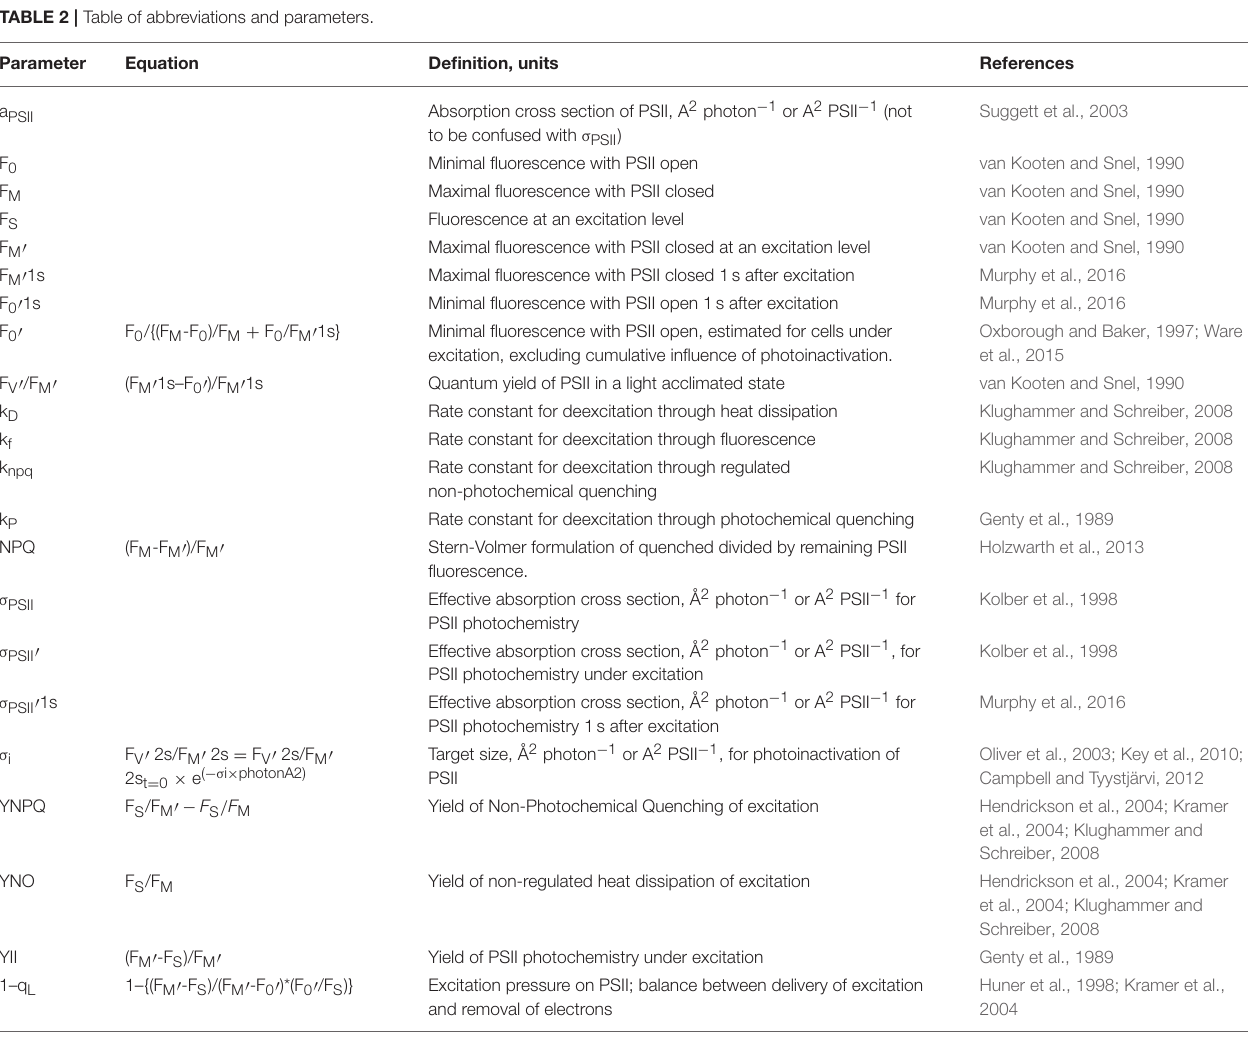
TABLE 2 | Table of abbreviations and